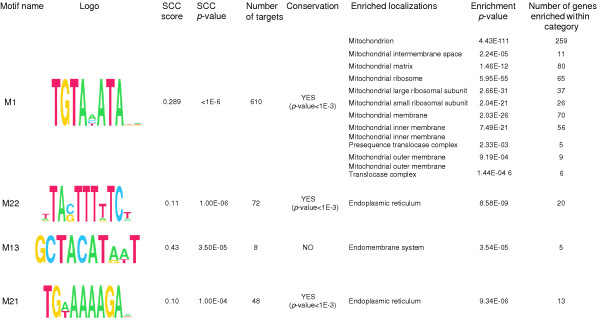
Examples of four of the 23 subcellular localization-associated motifs. Presented are motif name and logo, SCC score and p-value, number of target genes in whose 3' UTR the motif appears, and p-value for evolutionary conservation in other yeasts. Localization enrichment was computed by hypergeometric p-value, and only terms passing FDR at q-value = 0.1 are reported.